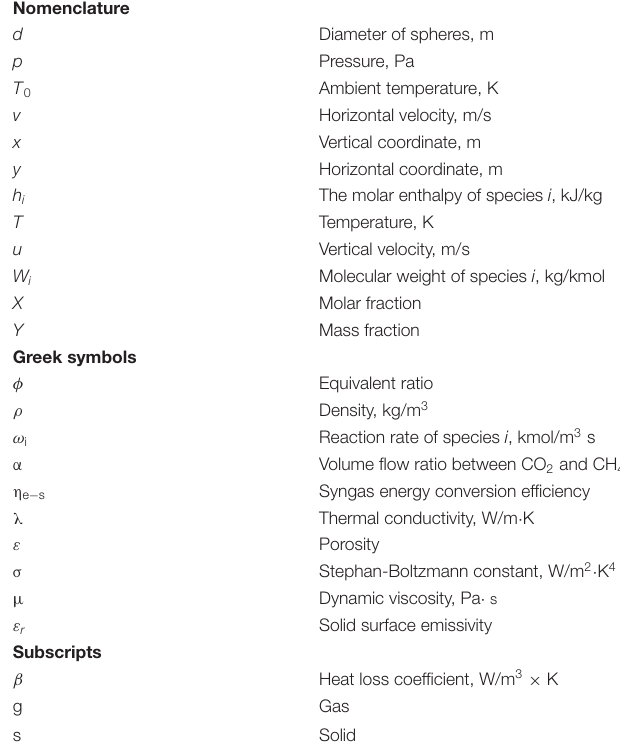
TABLE 1 | Symbols used in this work.